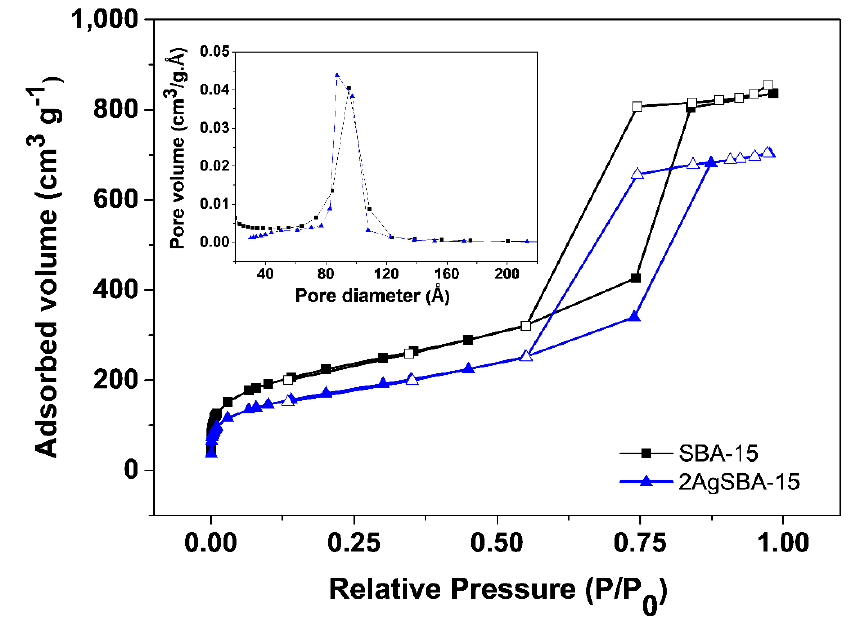
Figure 2. N 2 adsorption–desorption isotherms at 77 K and the corresponding Barrett–Joyner–Halenda (BJH) adsorption pore size distributions for the adsorbents.